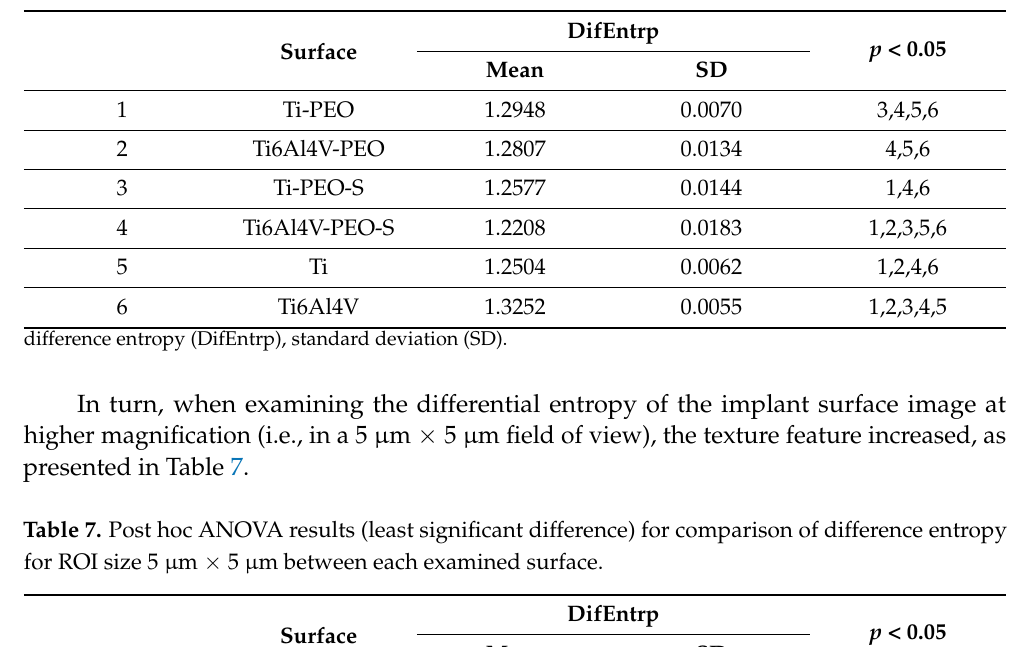
Table 7. Post hoc ANOVA results (least significant difference) for comparison of difference entropy for ROI size 5 µ m × 5 µ m between each examined surface.